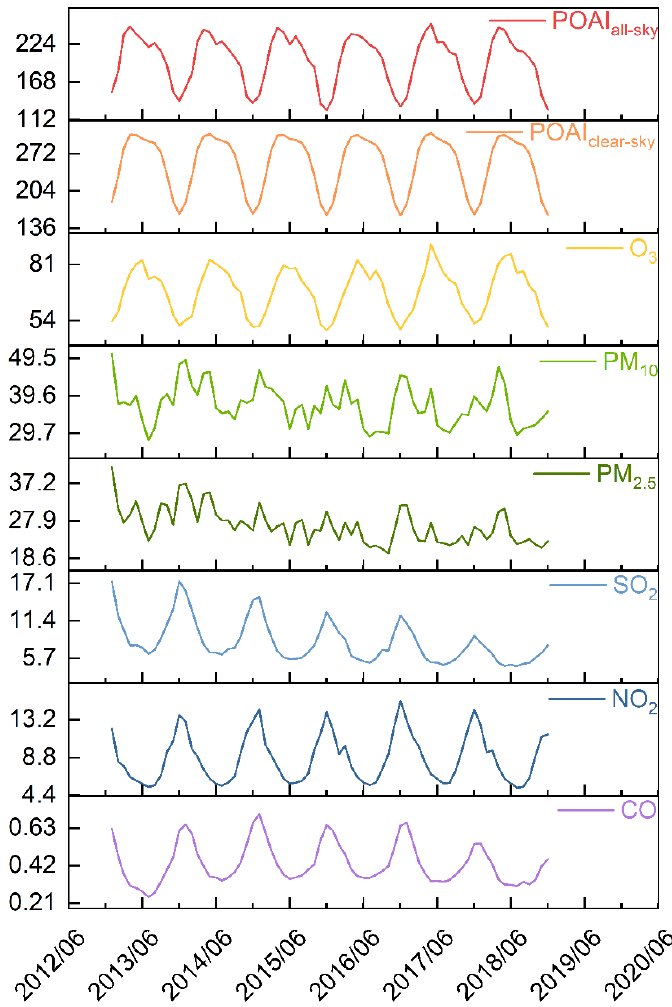
Figure 7. The temporal trends of POAI (Wm −2 ) and surface concentrations in six air pollutants (μgm −3 ) in China from 2013 to 2018.